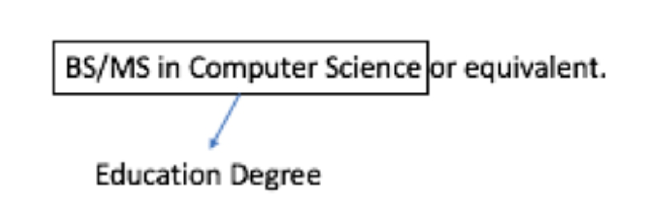
Figure 7. Sample of educational requirements in a job description. Table 8. A sample rule for education degree extraction using JAPE in SAJ.